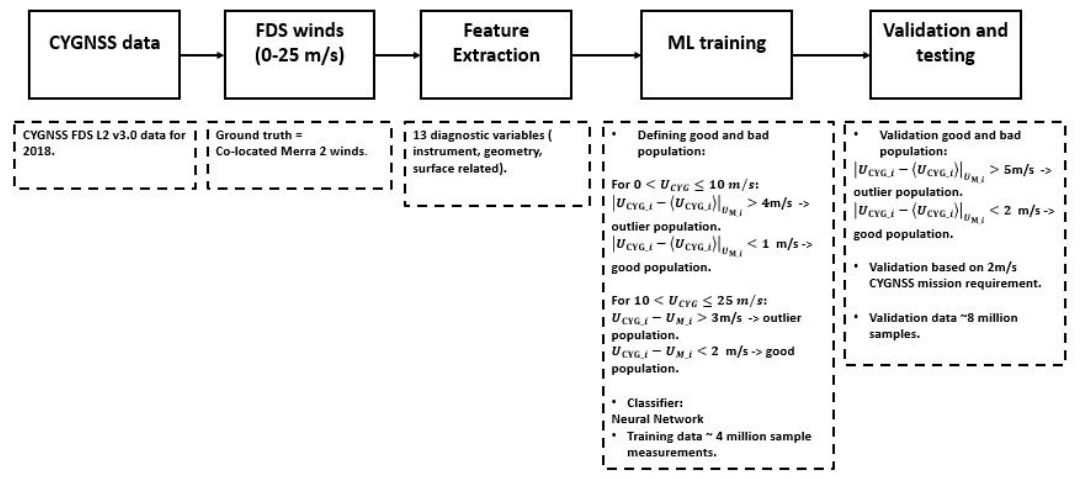
Figure 3. Steps involved in the new quality control algorithm for CYGNSS data. The algorithm has 3 major stages—Feature Extraction, ML training and Validation/testing.